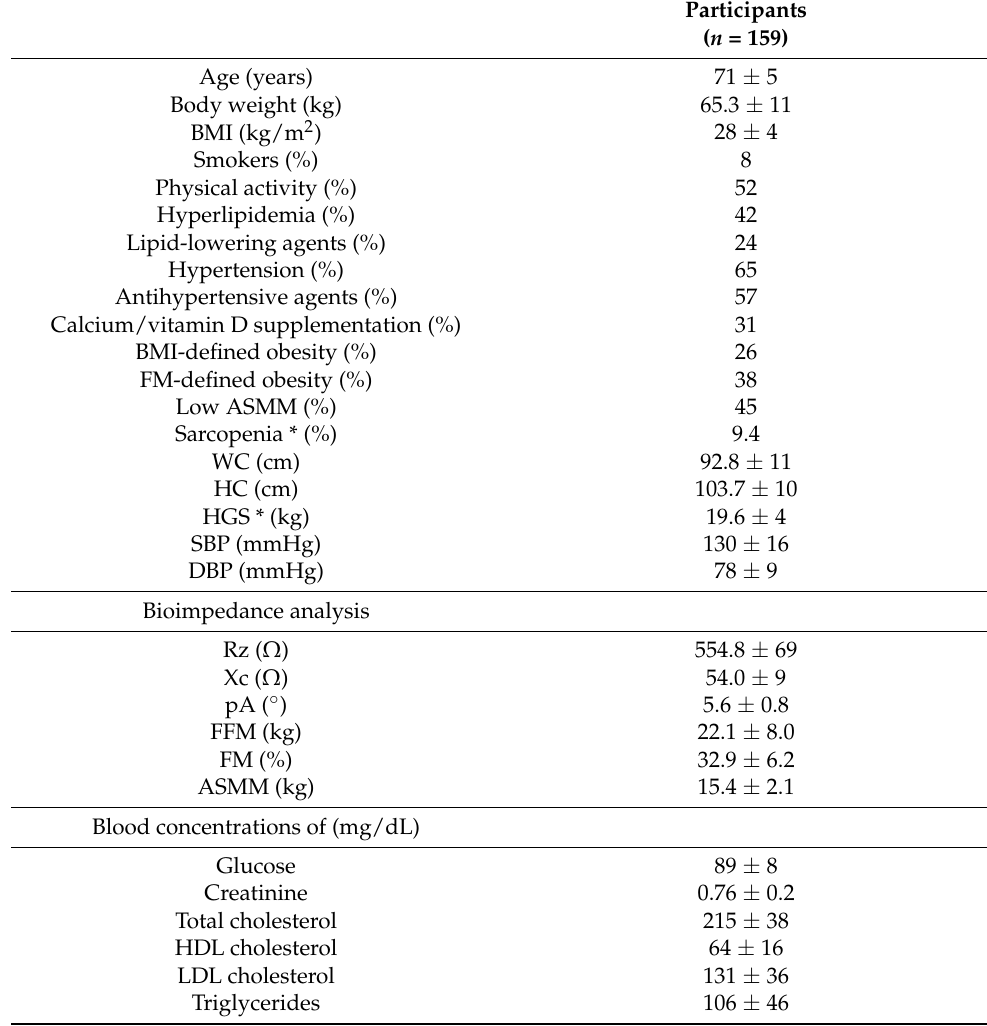
Table 1. Demographic, anthropometric, and clinical characteristics of the